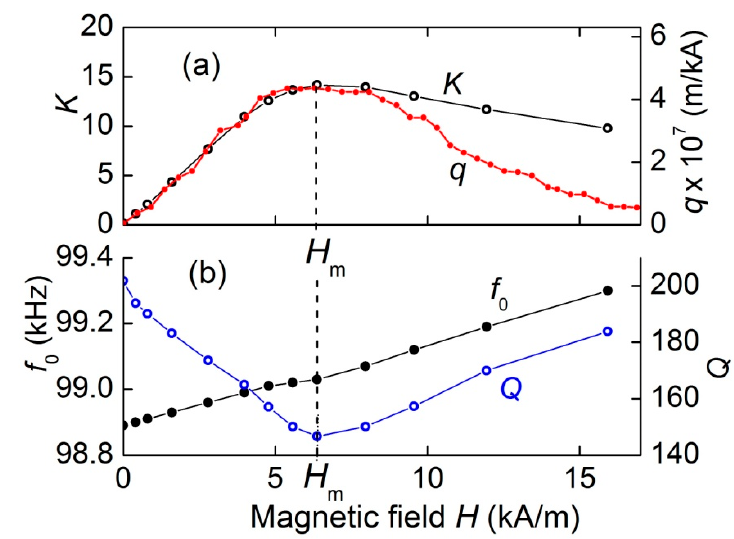
Figure 4. Field dependences of ( a ) the transformation ratio K and the piezomagnetic coefficient q , and ( b ) the resonance frequency f 0 as well as the quality factor Q under open-circuit condition. H m is the field of the maximum K value.